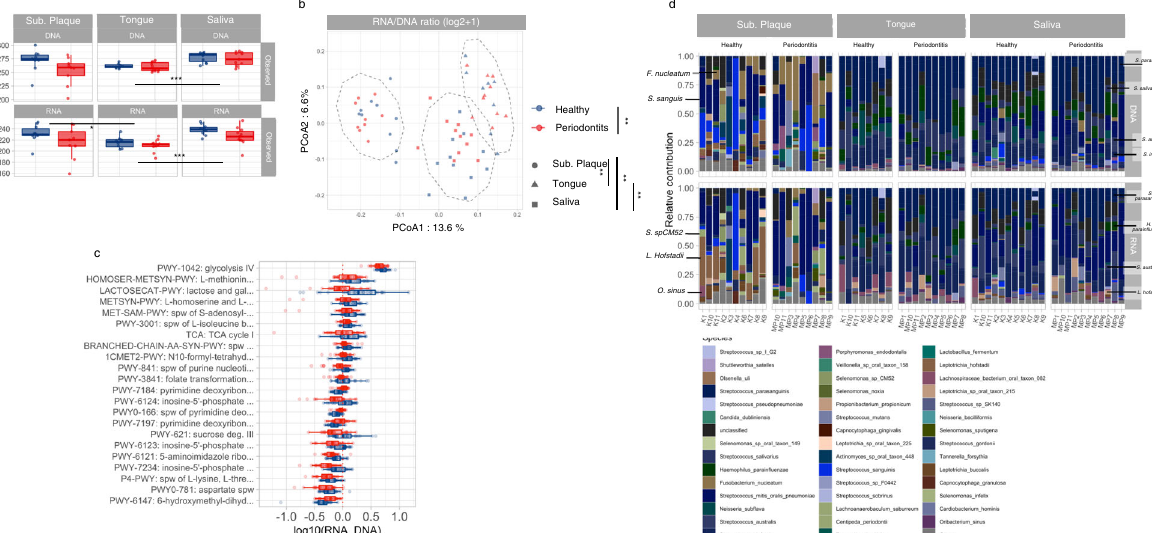
Fig. 3 Pathway diversity, differential expression, and contributing species. a α -diversity patterns of potential (DNA) and expressed (RNA) pathways as measured by observed richness, Pielou ’ s evenness and Shannon diversity index. b β -diversity of pathway expression as expressed by log(RNA/DNA ratio) and summarized using weighted Jaccard distance and visualized using PCoA ordination. Signi fi cant differences were assessed using Kruskal – Wallis and PERMANOVAS tests for α and β -diversity, respectively. Signi fi cant FDR-adjusted p values were indicated as follows: *0.05 > p > 0.01 **0.01 > p > 0.001, *** p < 0.001. c Pathways exhibiting signi fi cant differential expression between healthy and periodontitis patients as identi fi ed using MaAsLin2. Color indicates heath status (blue: healthy controls versus red: periodontitis group),